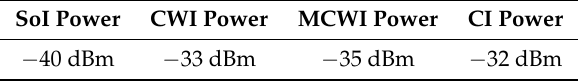
Table 2. Measured power of received signals.